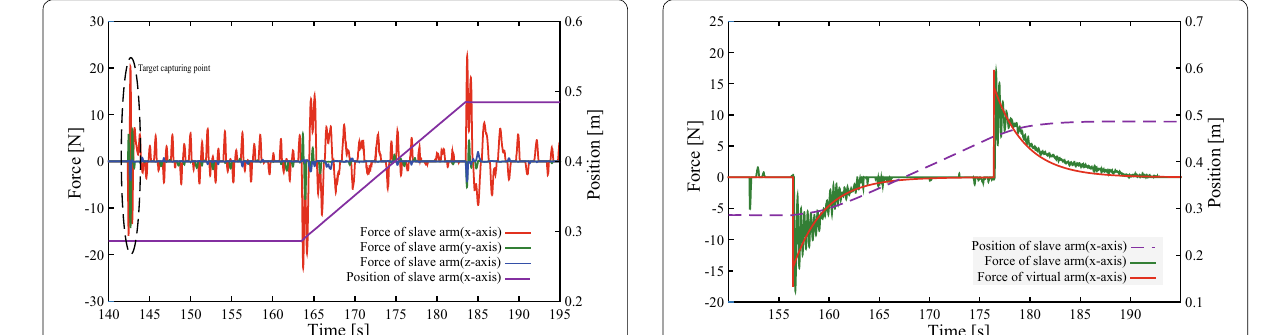
Fig. 12 Force of slave arm and virtual arm (x-axis) (in HILS